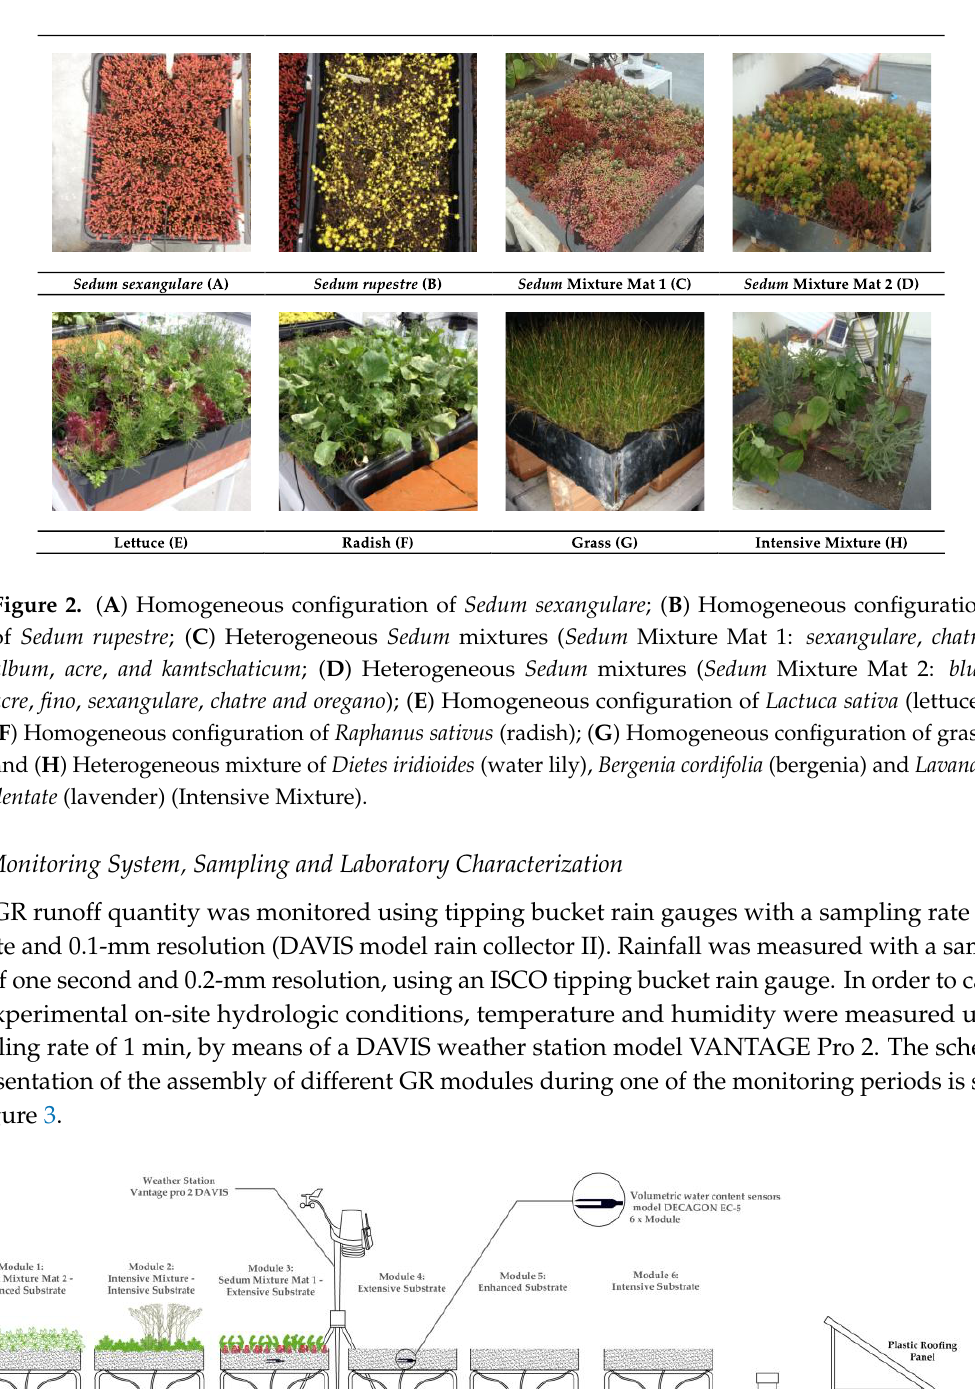
Figure 3. Experimental setup in the monitoring period from August 2015 to January 2017. RG: Rain gauge, WQP: water quality probe, SU: storage unit (used for measuring volume weighted concentrations).